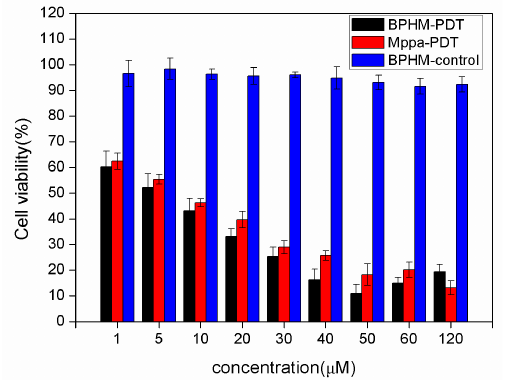
Figure 2. Cell viability of three groups: BPHM experiment groups (black columns), Mppa experiment groups (red columns) and control groups (blue columns). Each group was cultured with different concentrations of BPHM or Mppa (1, 5, 10, 20, 30, 40, 50, 60 and 120 μ M, 200 μ L), cell viability was assessed by MTT assay after 24 h. Statistically significant between BPHM and Mppa experiment groups were performed by t -test, p < 0.05 showed the difference was significant).